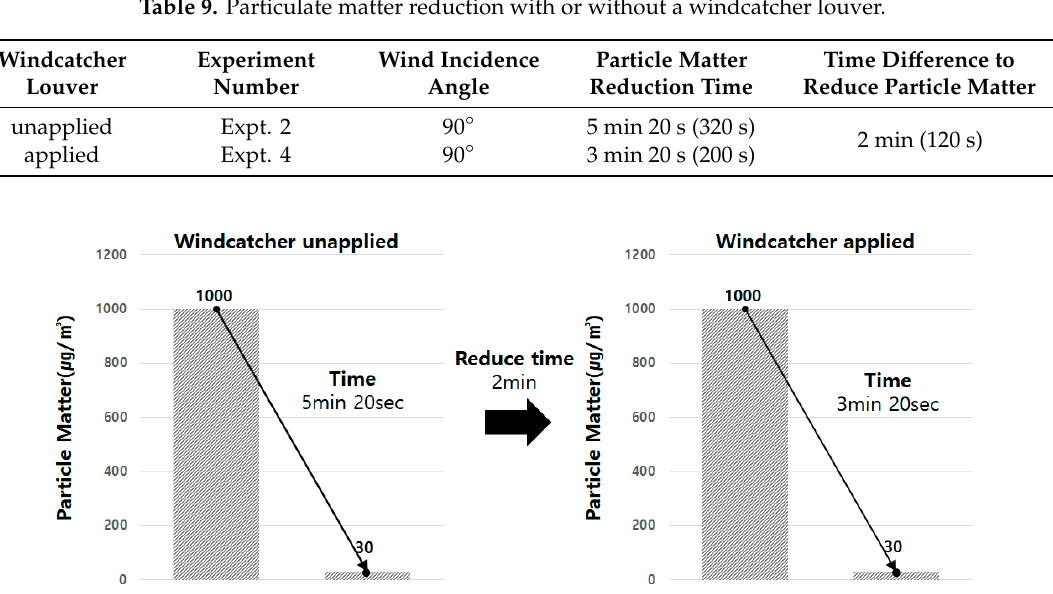
Figure 20. Comparison of the ventilation performance for different configurations of windcatcher Figure20. Comparisonoftheventilationperformancefordi ff louver.